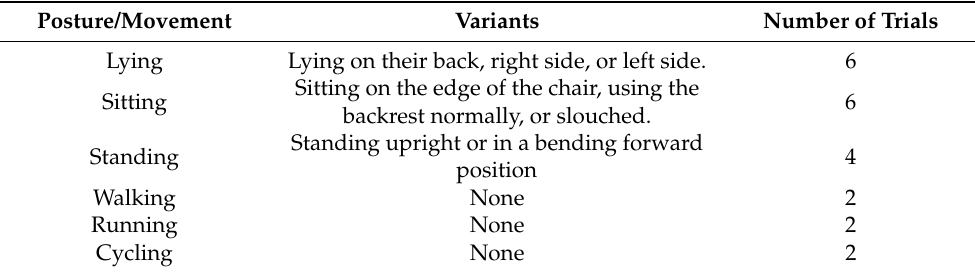
Table 1. Summary of the performed trials of the first phase. The postures consisted of several variants and the movements were performed at the preferred speed of each participant.